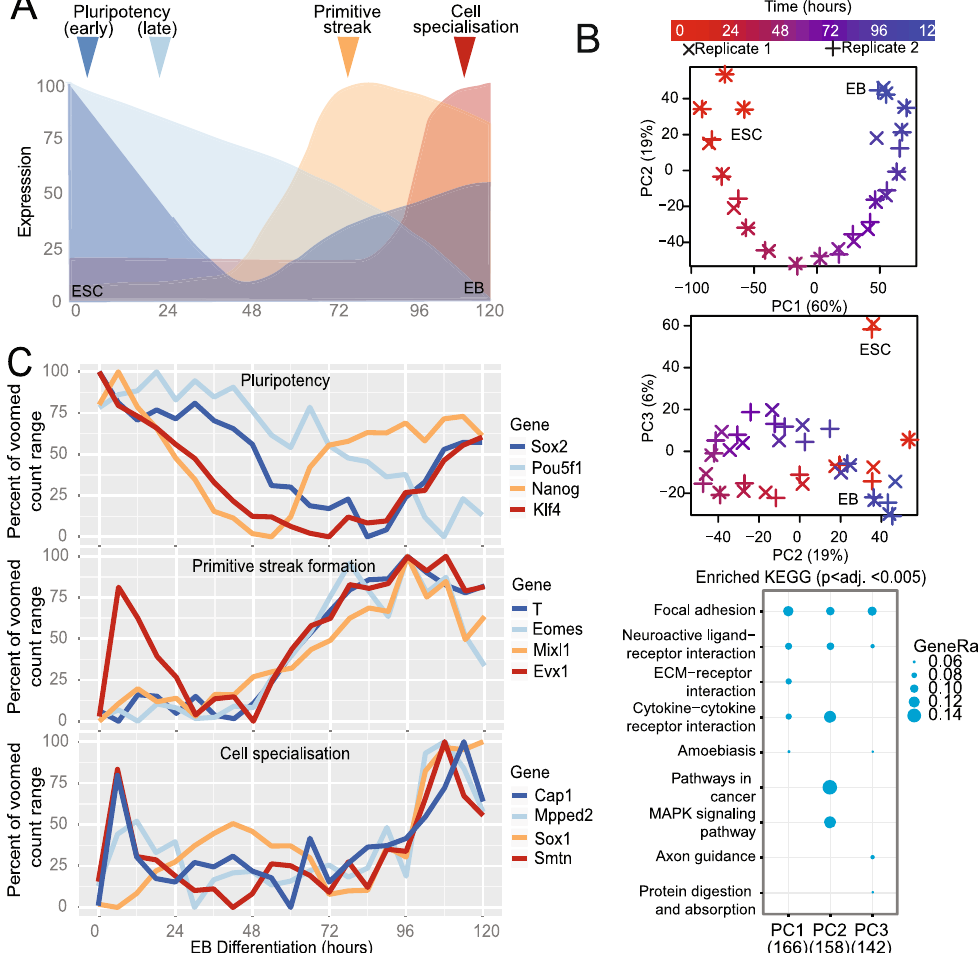
Figure 1. Global and gene-specific evaluation of augmented temporal resolution in mES differentiation. ( A ) Schematic of mouse embryonic stem cell (ESC) differentiation into embryoid bodies (EB) over the time course evaluated here. ( B ) Analysis of the top three principle components (PCs) based on the 2,000 most variable genes from biological duplicate-6 hourly transcriptomes and KEGG pathway enrichment for 500 genes contributing most to each of the top three PCs. ( C) Expression profiles of genes associated with pluripotency, primitive streak formation and cell